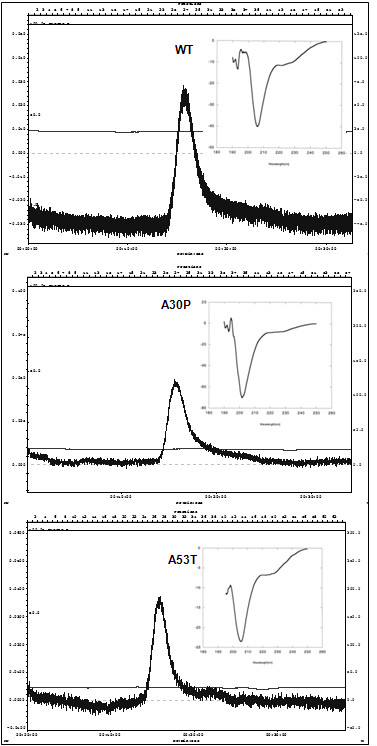
Purified E-coli α-syn is monomeric and unstructured. Each recombinant α-syn (Wt, A30P and A53T) was analyzed by size exclusion chromatography to determine the presence of monomeric, dimeric, or other higher order forms. Eluate peaks (fraction 27) were then assessed by circular dichroism spectra to define the secondary structure of the α-syn proteins (Inset). Far-UV circular dichroism spectra were recorded on an Aviv circular dichroism spectrometer model 62DS (Lakewood, NJ, USA) at 25°C using quartz cells with a path length of 0.1 cm. Spectra were obtained from 195 nm to 260 nm, with a 1.0-nm step, 1.0-nm bandwidth, and 4-s collection time per step. The experimental data were expressed as mean residue ellipticity (θ) (deg·cm2·dmol-1). Only monomeric forms of α-syn where identified by size exclusion chromatography, and all α-syn share similar random secondary structure.